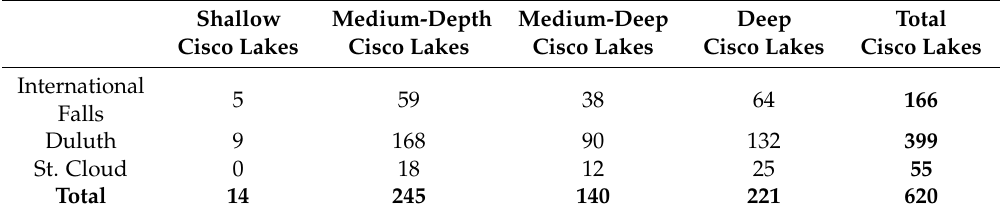
Table 3. 620 cisco lakes in Minnesota, grouped by three weather stations (Duluth, International Falls, and St. Cloud) and lake maximum depth in four categories: shallow cisco lakes ( H max ≤ 5 m), medium-depth cisco lakes (5 m < H max ≤ 15 m), medium-deep cisco lakes (15 m < H max ≤ 20 m) and deep cisco lakes ( H max > 20 m). Shallow Medium-Depth Medium-Deep Deep Total Cisco Lakes Cisco Lakes Cisco Lakes Cisco Lakes Cisco Lakes International 5 59 38 64 166 Falls Duluth